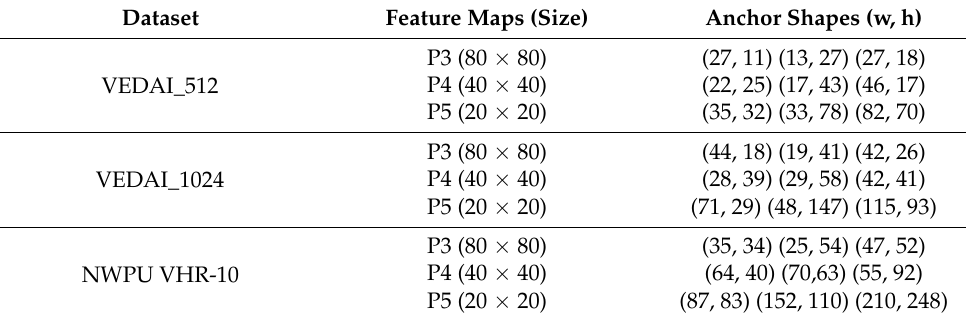
Table 1. Anchor shapes for each feature map.